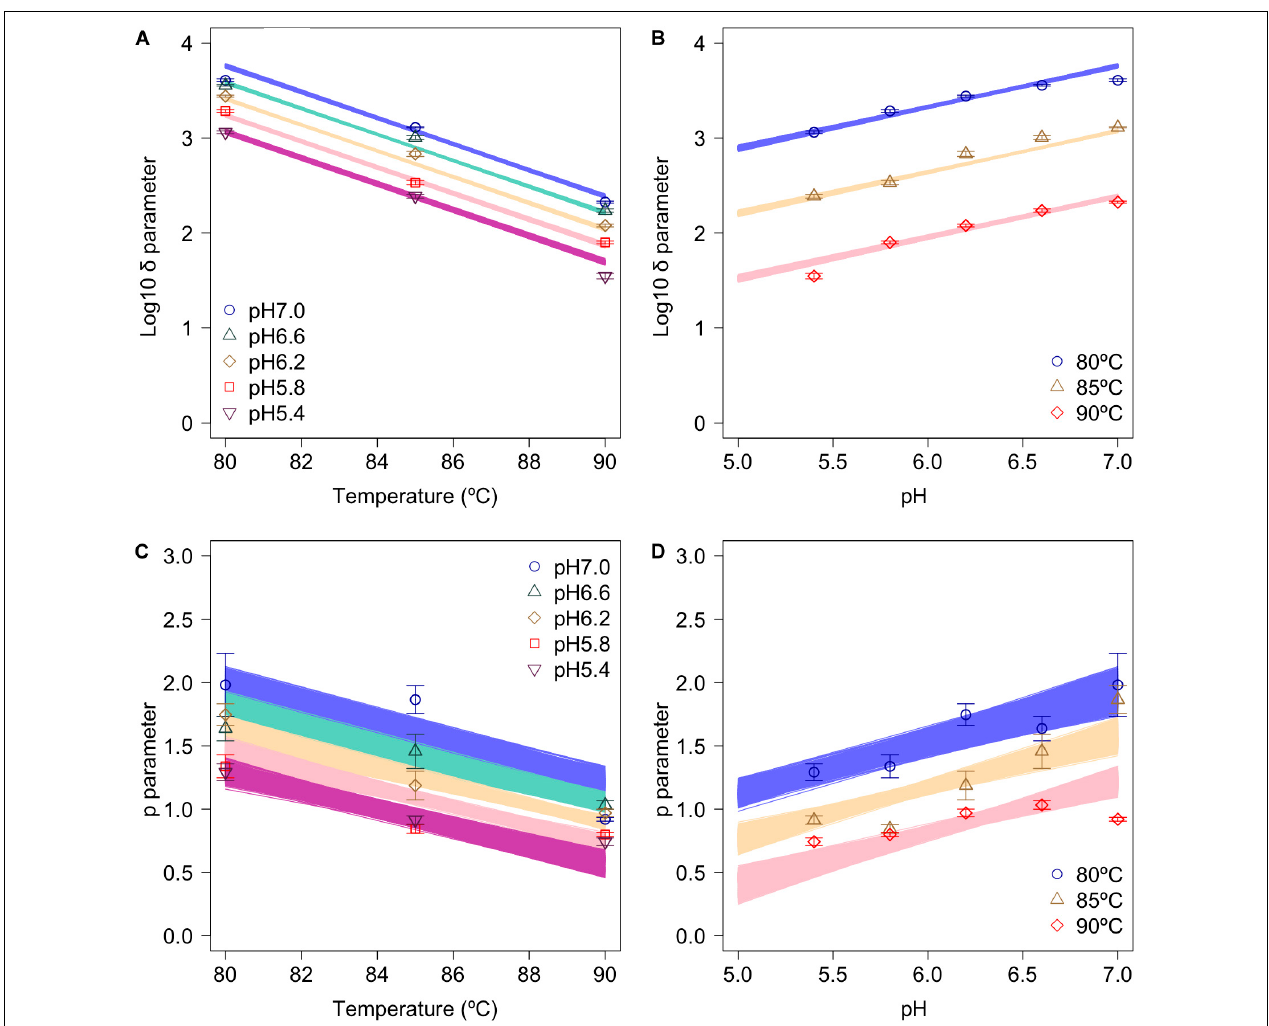
FIGURE 6 | Changes in log 10 δ and p as functions of heating temperature and pH (data points). (A) log 10 δ against temperature; (B) log 10 δ against pH; (C) p against temperature; and (D) p against pH. Error bars indicate standard deviation of the 1,000 estimated Weibullian parameter replicates; lines indicate secondary model ( A,B : Eq. 2; C,D : Eq. 3) derived from 1,000 bootstrap